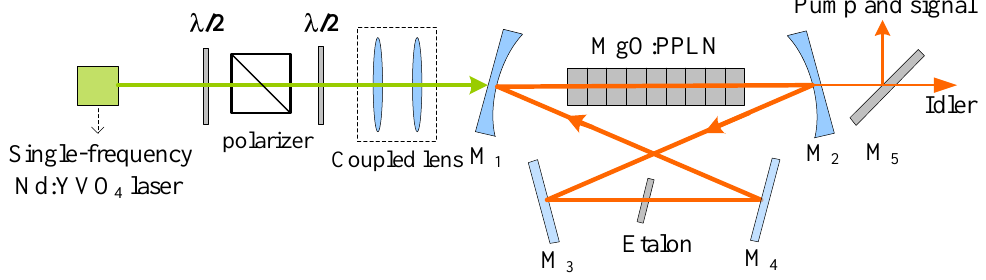
Figure 1. Configuration of the continuous-wave (CW) single-frequency MgO-doped periodically poled lithium niobate (MgO:PPLN) optical parametric oscillator (OPO).